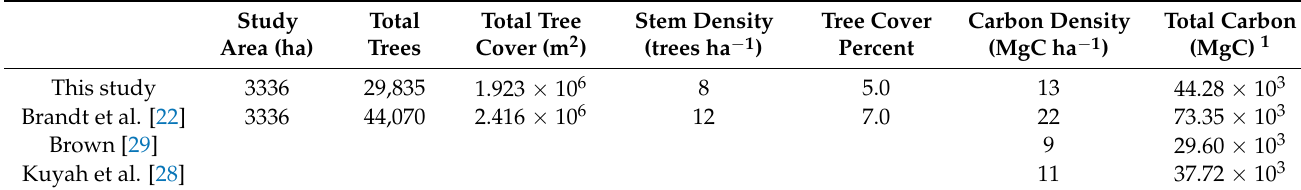
Table 2. Carbon stock estimates. Results of this study analysis and compared using the alternative tree cover map from Brandt et al. and carbon stocks using two alternative allometric